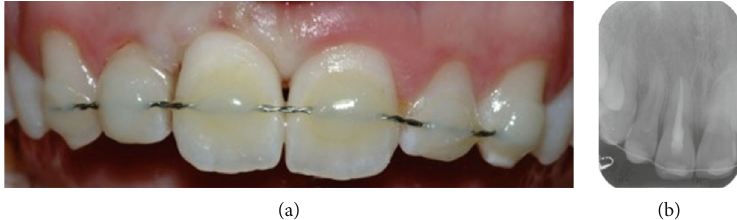
Figure 2: (a) Clinical and (b) radiographic view of the upper incisor after reimplantation and splint.